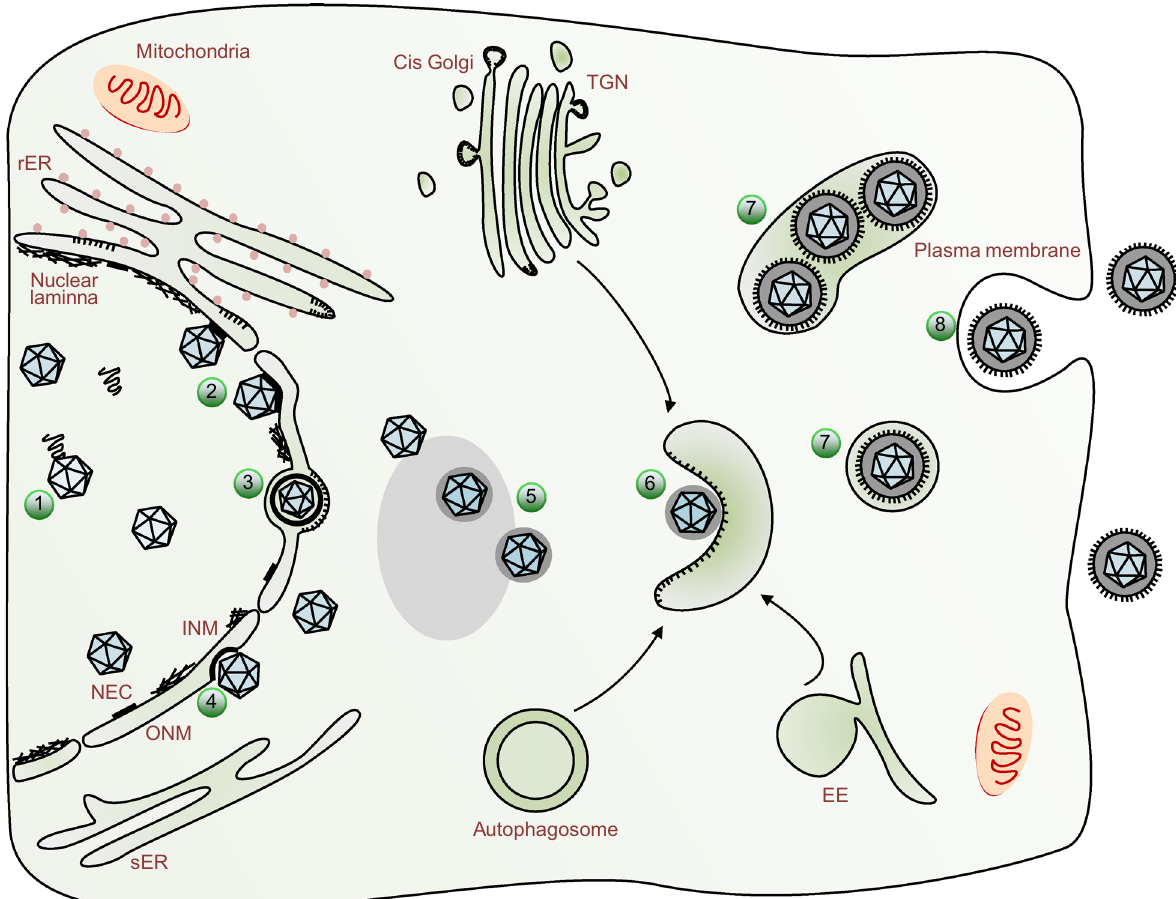
Figure 1. A schematic representation of herpesvirus assembly and egress. In the nucleus, newly synthesized viral genomes are packaged into the capsids (1). The nascent nucleocapsids traf fi c to the inner nuclear membrane (INM) where nuclear egress complex (NEC) are anchored and the nuclear lamina has been dissolved by host or viral kinases (2). Nucleocapsids bud at the INM, forming primary enveloped virions in the perinuclear space (3, primary envelopment). The primary envelopes of virions then fuse with the outer nuclear membrane (ONM), releasing the nucleocapsids into the cytoplasm (4, deenvelopment). In the cytoplasm, nucleocapsids acquire tegument proteins at electron-dense deposits, which is obvious in transmission electron microscopy micrograph (5). The tegumented capsids bud into special vesicles (6) that may derive from trans-Golgi network (TGN), early endosome (EE) or autophagosome, and form mature virions inside vesicles (7, secondary envelopment). Finally, these vesicles fuse with the plasma membrane and release mature virions to extracellular space